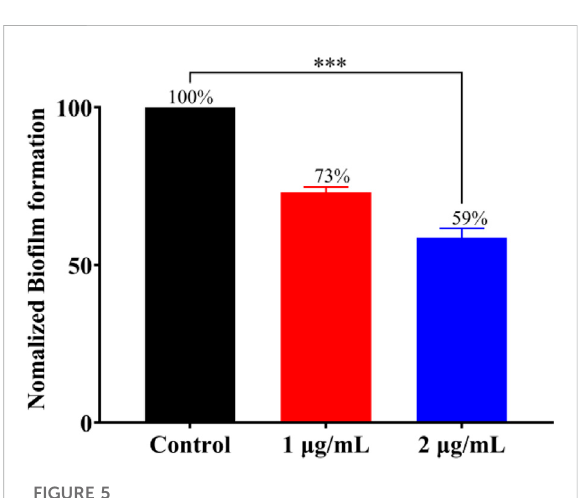
FIGURE 5 The effect of Ru-3 (1 μ g ml − 1 and 2 μ g ml − 1 ) on the bio fi lm formation of Staphylococcus aureus